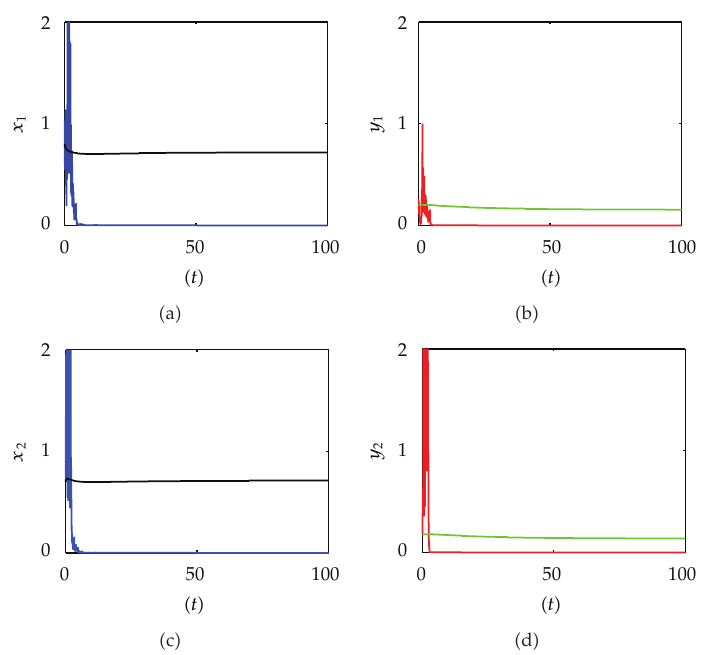
Figure 7: The solution of stochastic system compared to the deterministic system: σ 11 (cid:5) 1 . 4 ,σ 12 (cid:5) 1 . 5 ,σ 21 (cid:5) 0 . 01 ,σ 22 (cid:5) 0 . 01. The prey population su ff er the large white noise which leads to the prey and predator extinction. The blue and red lines represent the solutions of system (cid:2) 5.1 (cid:3) , and the black and green lines represent the solutions of corresponding undisturb